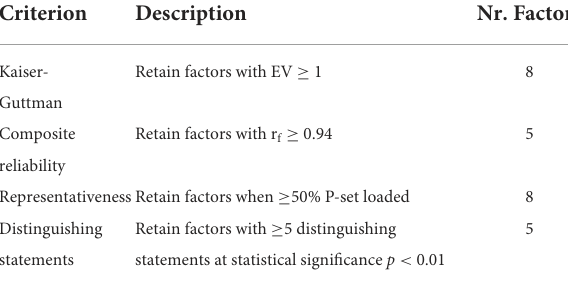
TABLE 3 Factor retention criteria, description, and